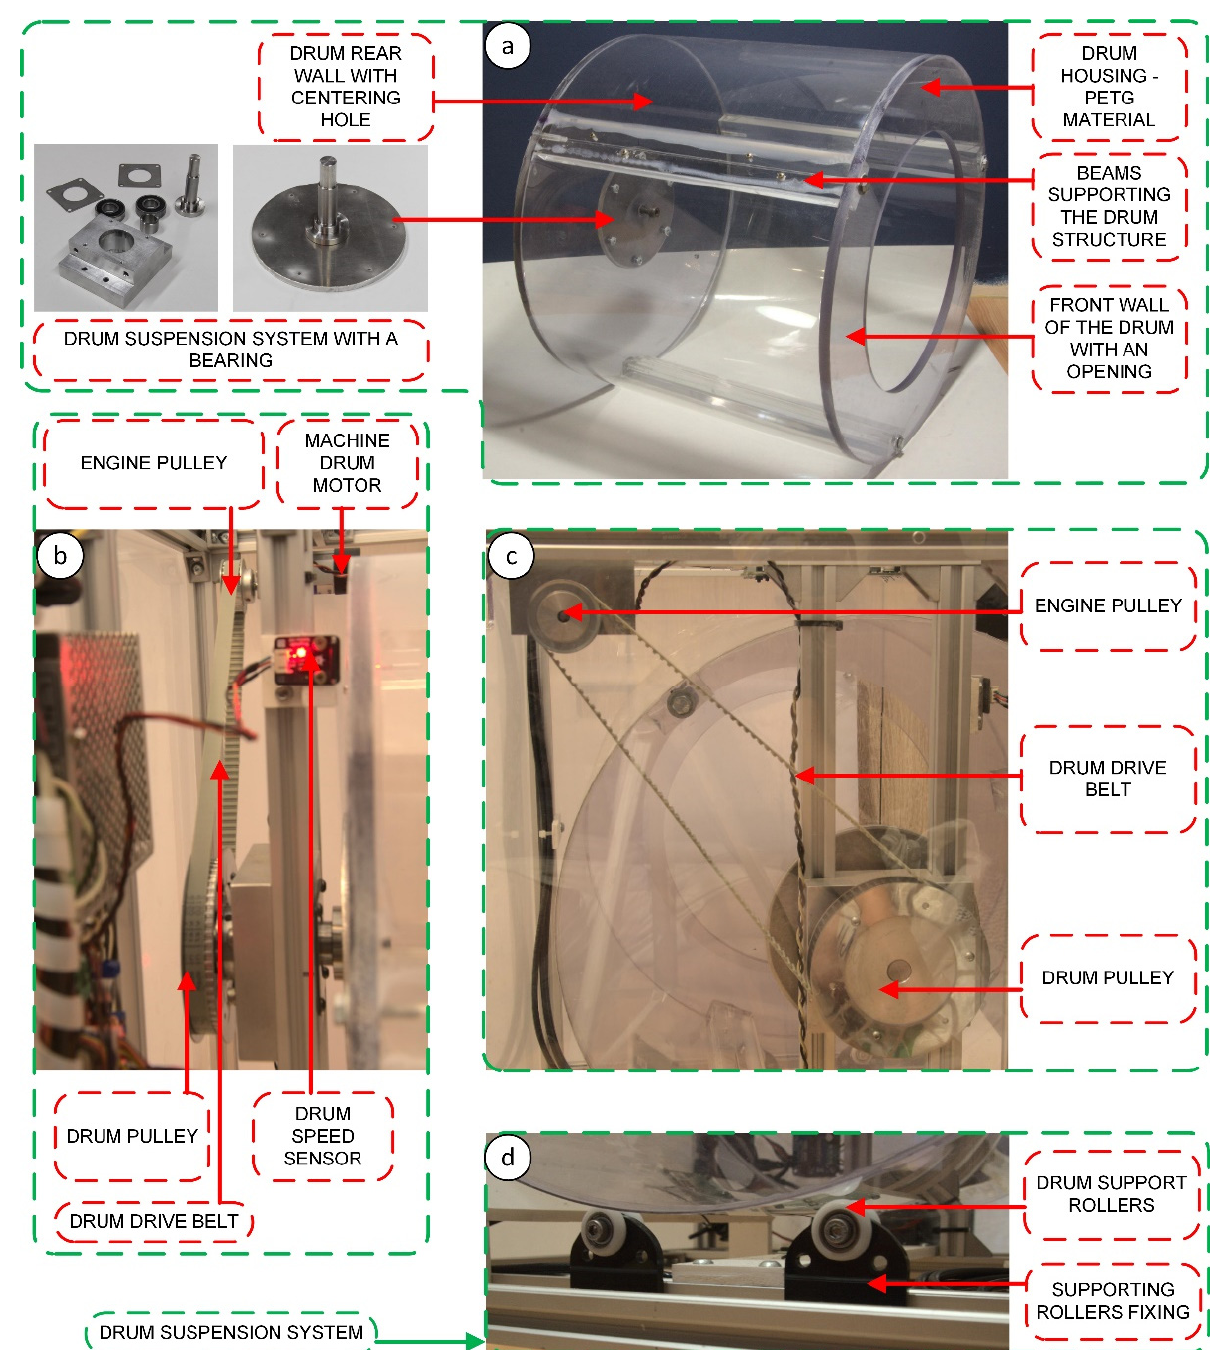
Figure 9. Mechanical design of the developed IoTT ‐ enabled washing machine demonstrator: ( a ) drum and its suspension view; ( b ) side view of the device; ( c ) rear view of the developed device; and ( d ) drum suspension system.